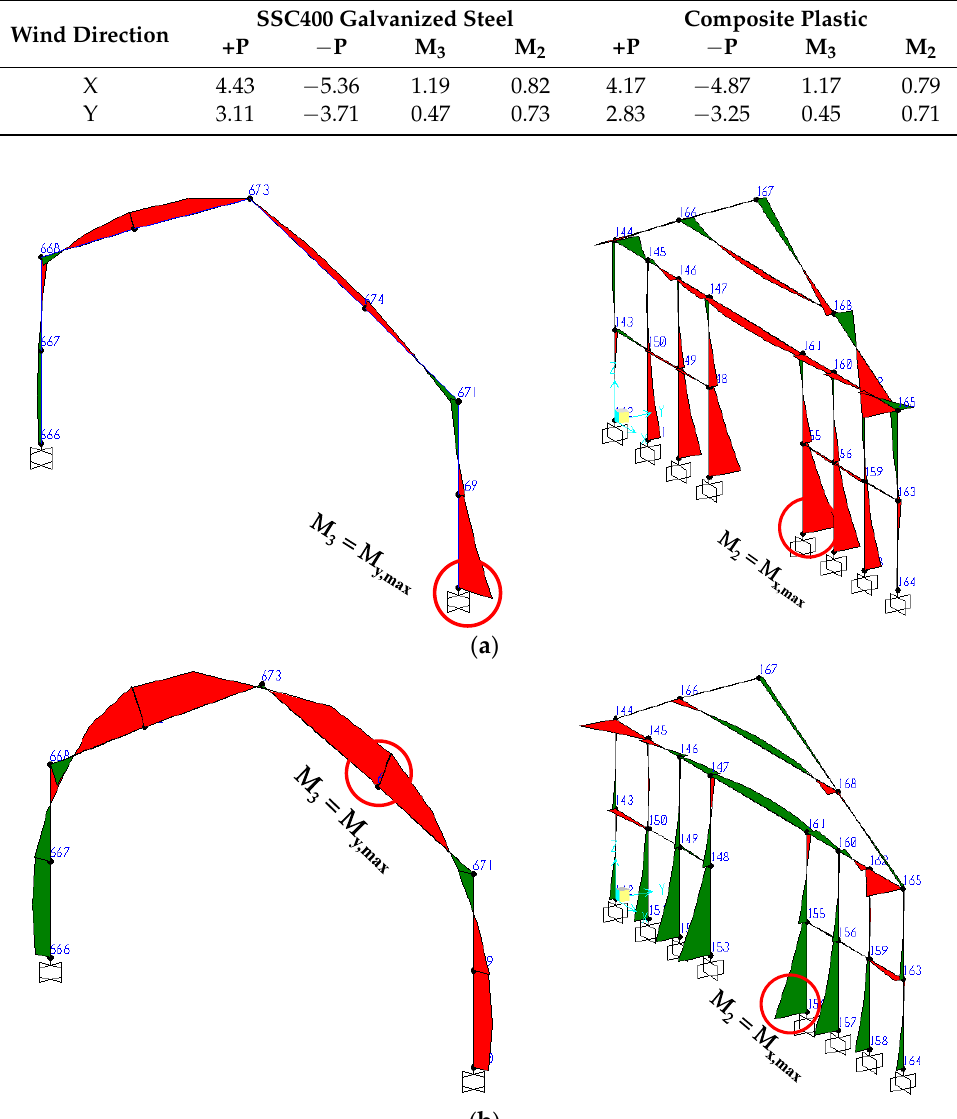
Figure 4. ( a ). Locations of maximum moment under the transverse wind load. ( b ). Locations of maximum moment under the longitudinal wind load.